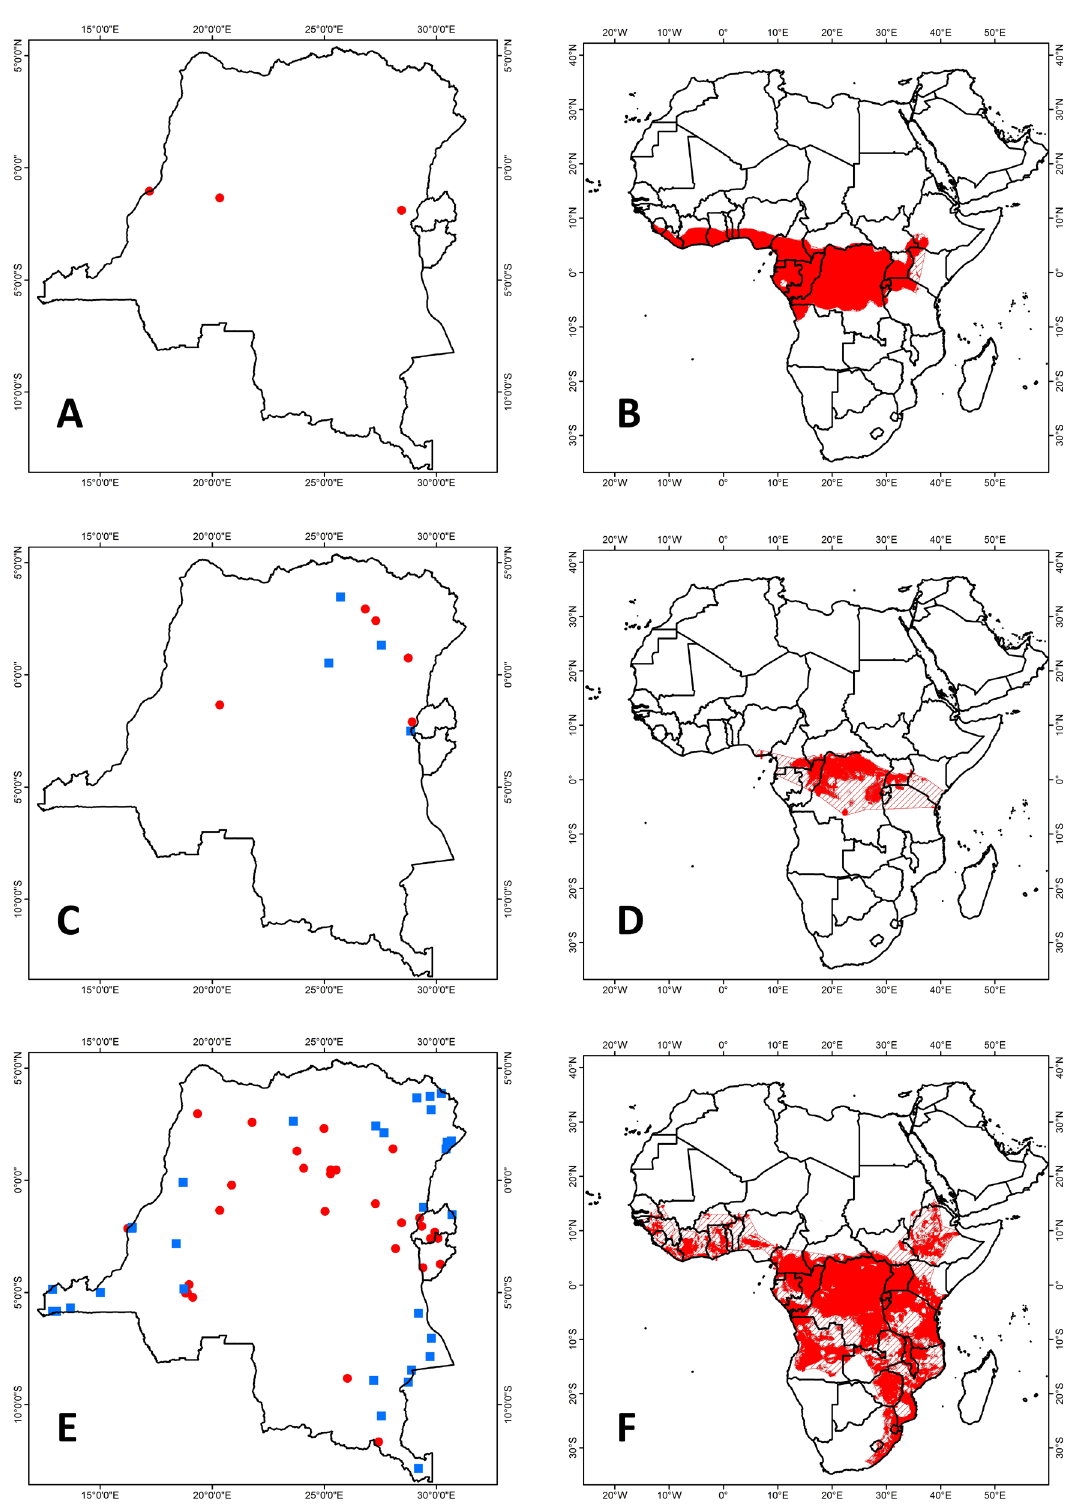
Fig. 35. Distribution maps. A–B . Kerivoula phalaena Thomas, 1912. C–D . Kerivoula smithii Thomas, 1880. E–F . Myotis bocagii (Peters, 1870). A, C, E. Distribution in the CRB area. B, D, F. Pan-African